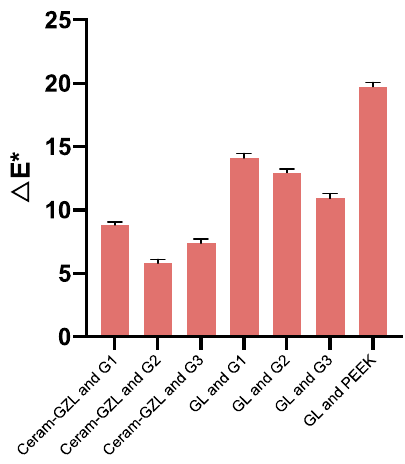
Figure 10. The color difference between PEEK specimens and gingiva shade.